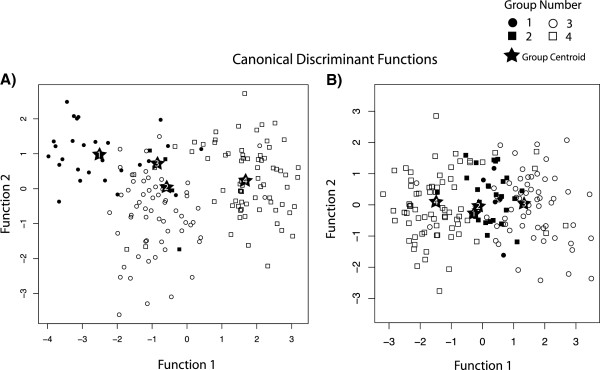
Canonical discriminant function analysis (DFA) of genetic groups of Pteronotus parnellii shows significant divergence. (A) Sympatric groups 3 and 4 show greater separation when the data are corrected for correlations with latitude. (B) Group centroids are marked with a star.